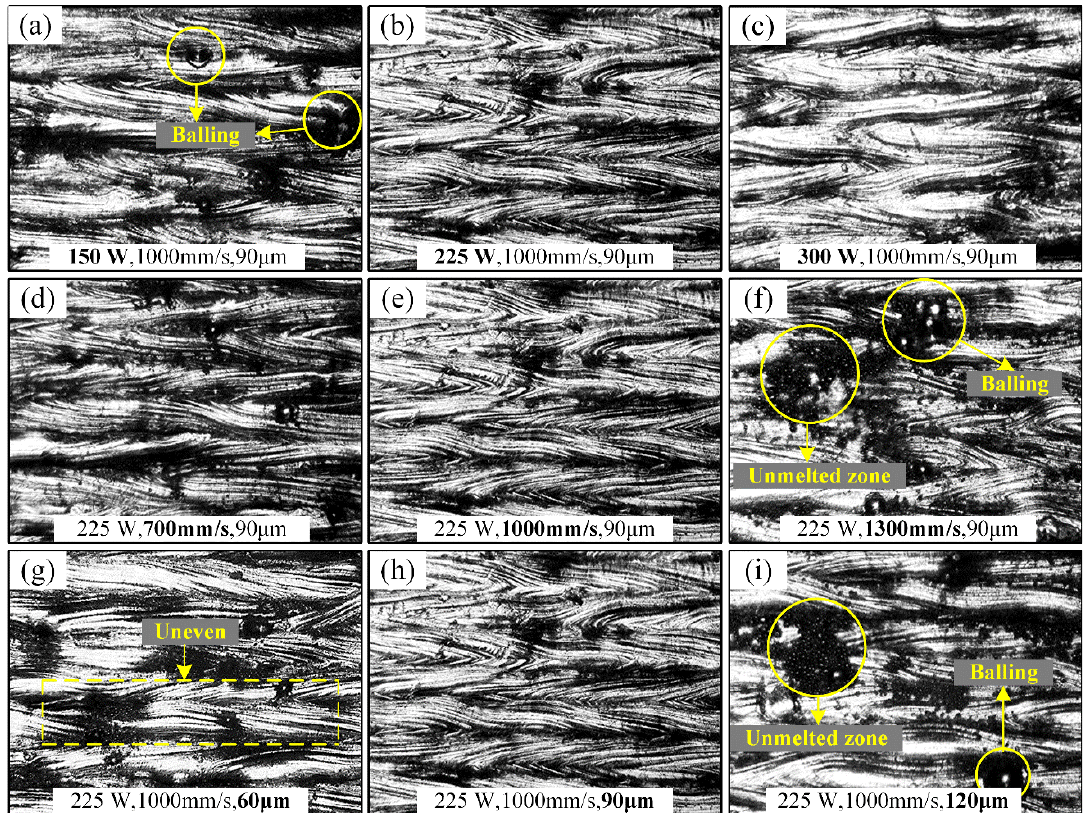
Figure 4. Surface morphologies of parts with different P values of ( a ) 150 W, ( b ) 225 W and ( c ) 300 W, and different V values of ( d ) 700 mm/s, ( e ) 1000 mm/s and ( f ) 1300 mm/s, and different S values of ( g ) 60 μm, ( h ) 90 μm and ( i ) 120 μm.